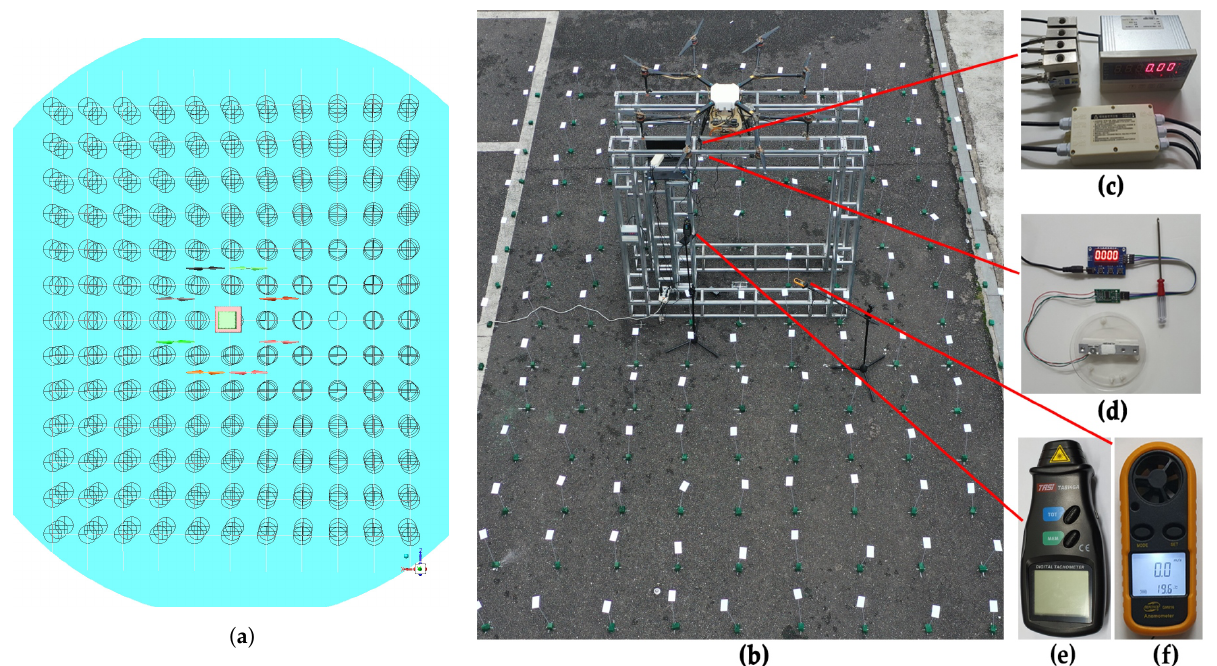
Figure 3. Data acquisition of lift and wind velocity. ( a ) shows the sample points in the simulation. ( b ) shows the scene in the experiment. ( c – f ) show the positive and negative force sensors of UAV’s landing gears, laser tachometer, and anemometer.